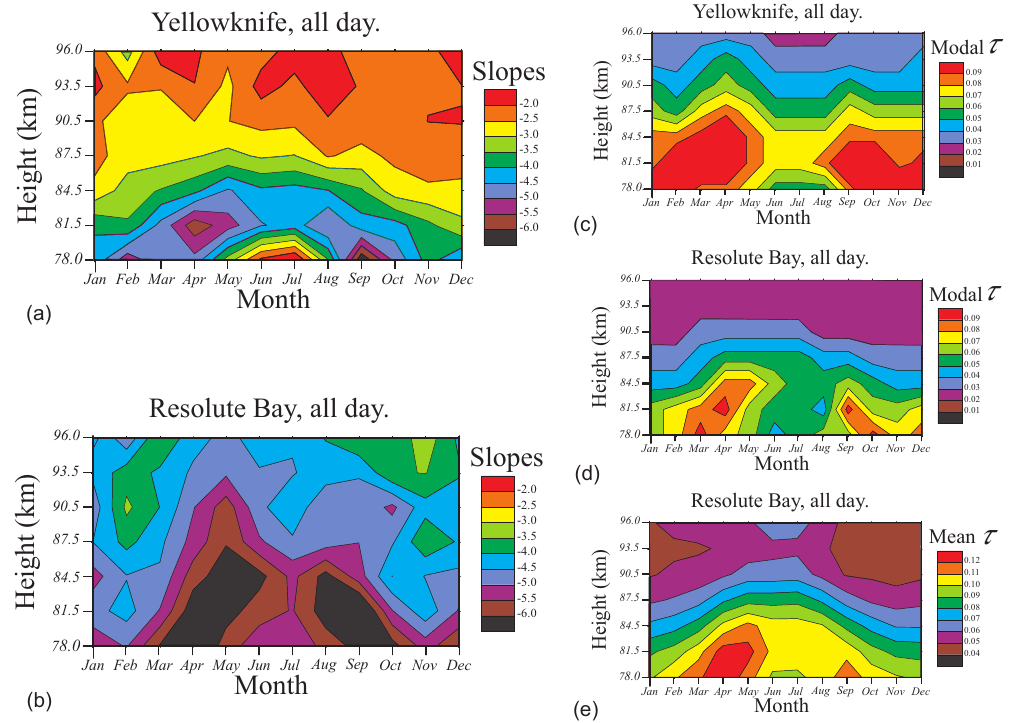
Figure 6. Panels (a) and (b) show contour plots of the slope of the tail of the CCD, as described in the text, as a function of height and month, for Yellowknife and Resolute Bay respectively. Data cover the full range of available years. Panels (c) to (e) show contour plots of the modes and means of the total distribution, as described in each figure. These last three plots do not pertain directly to the non-underdense meteors but instead apply more to the underdense ones. The purpose of displaying them is discussed in the text. Note that the ordinate shows the midpoints of the height bins; the lowest and highest bins are 4km thick, while all others are 3km thick.